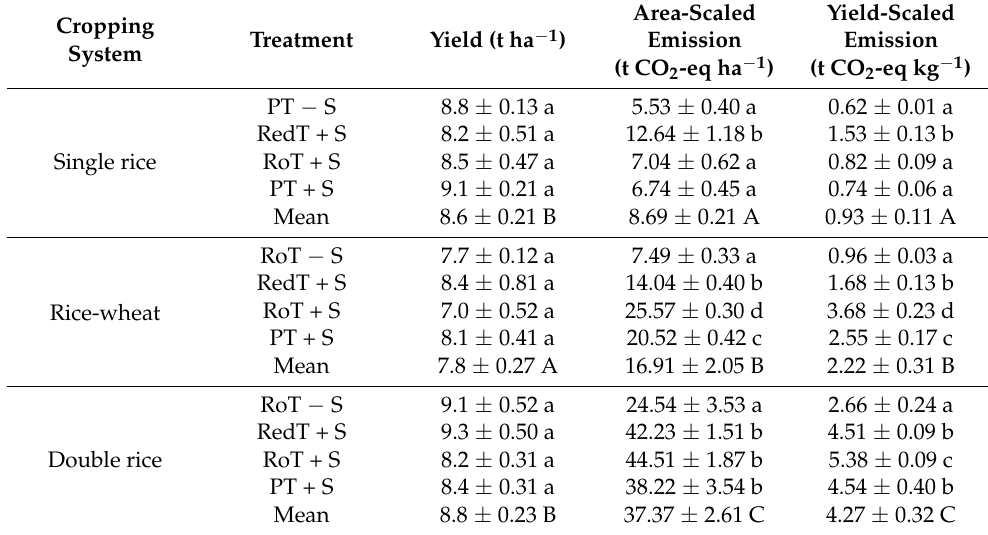
Table 2. Impacts of straw incorporated tillage patterns on rice yield, area and yield-scaled emissions.